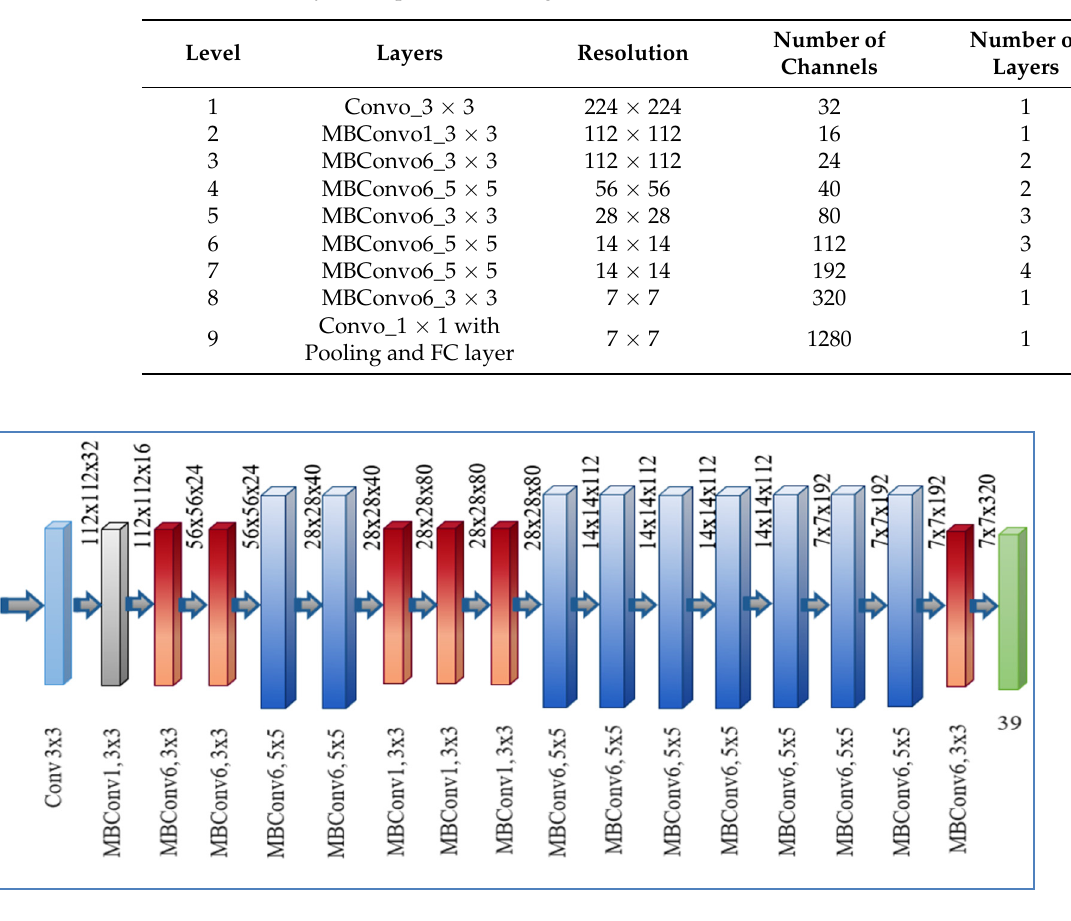
Figure 5. Systematic diagram of EfficientNet B7 architecture for leaf disease detection.